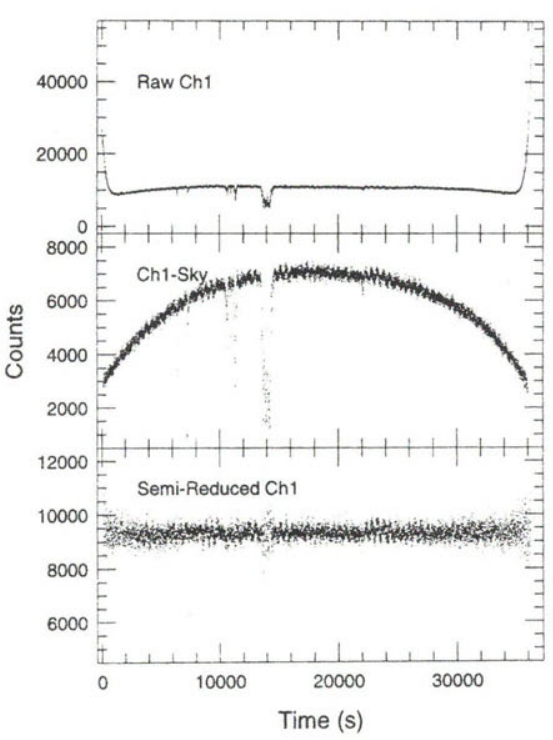
Fig. 5. Observing in twilight and cloud with the WET